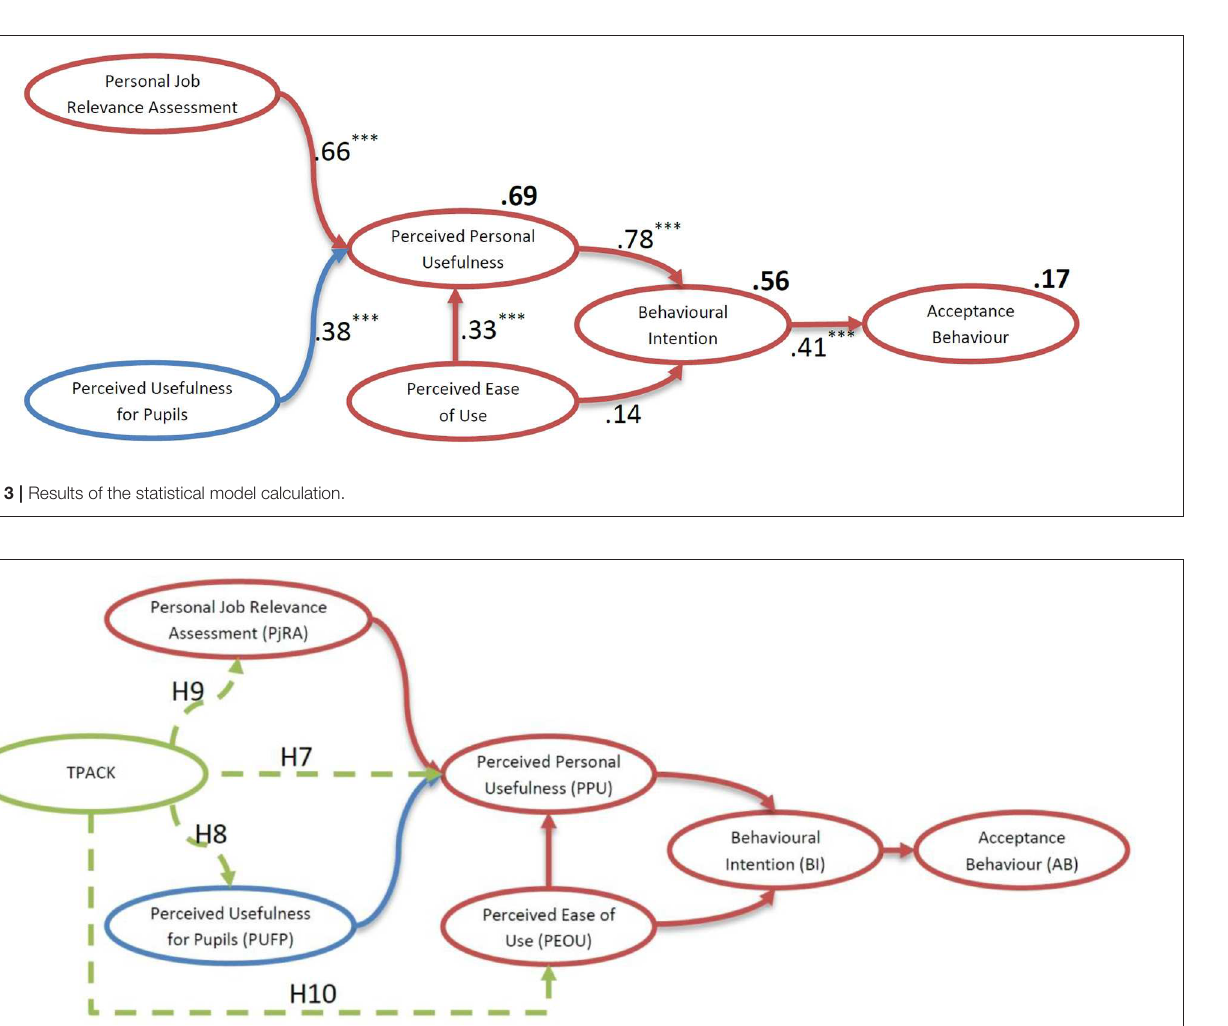
FIGURE 4 | Conceptual model of the adapted UTAUT model with TPACK